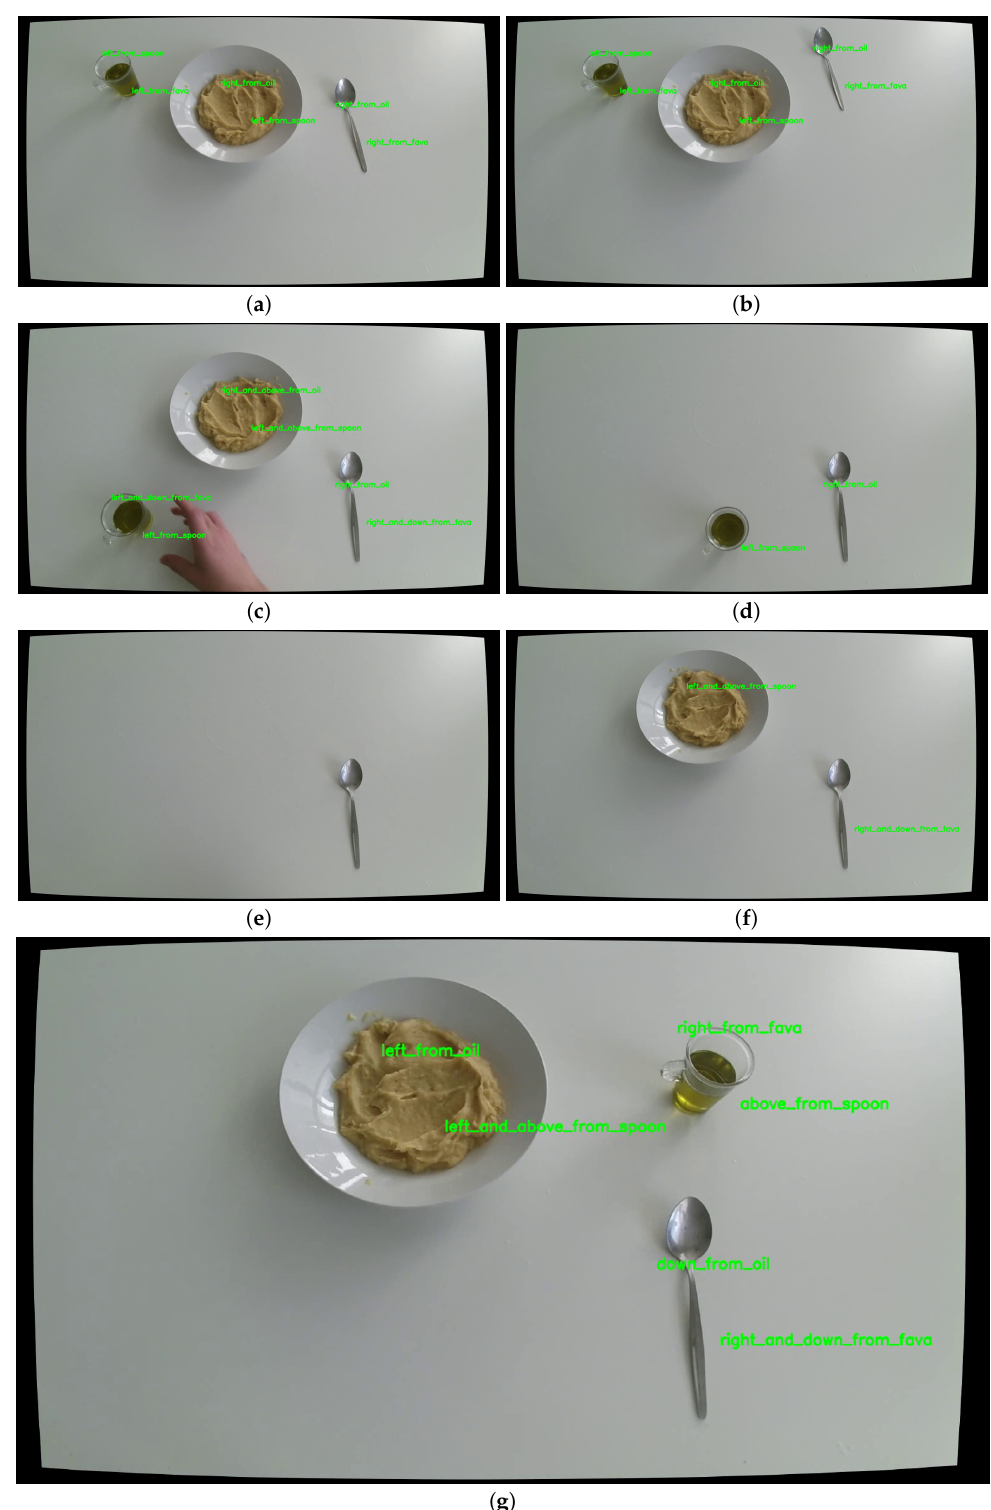
Figure 14. The spatial arrangement of objects at successive frames: ( a ) initial state, ( b ) spoon has been moved but is still in the right of the plate, ( c ) both oil and spoon have moved downwards, ( d ) plate has been removed from the scene and the labels have adapted, ( e ) only the spoon appears in the scene so no information is shown, ( f ) plate has reappeared, ( g ) all three objects are in the scene and appropriate relative positions are